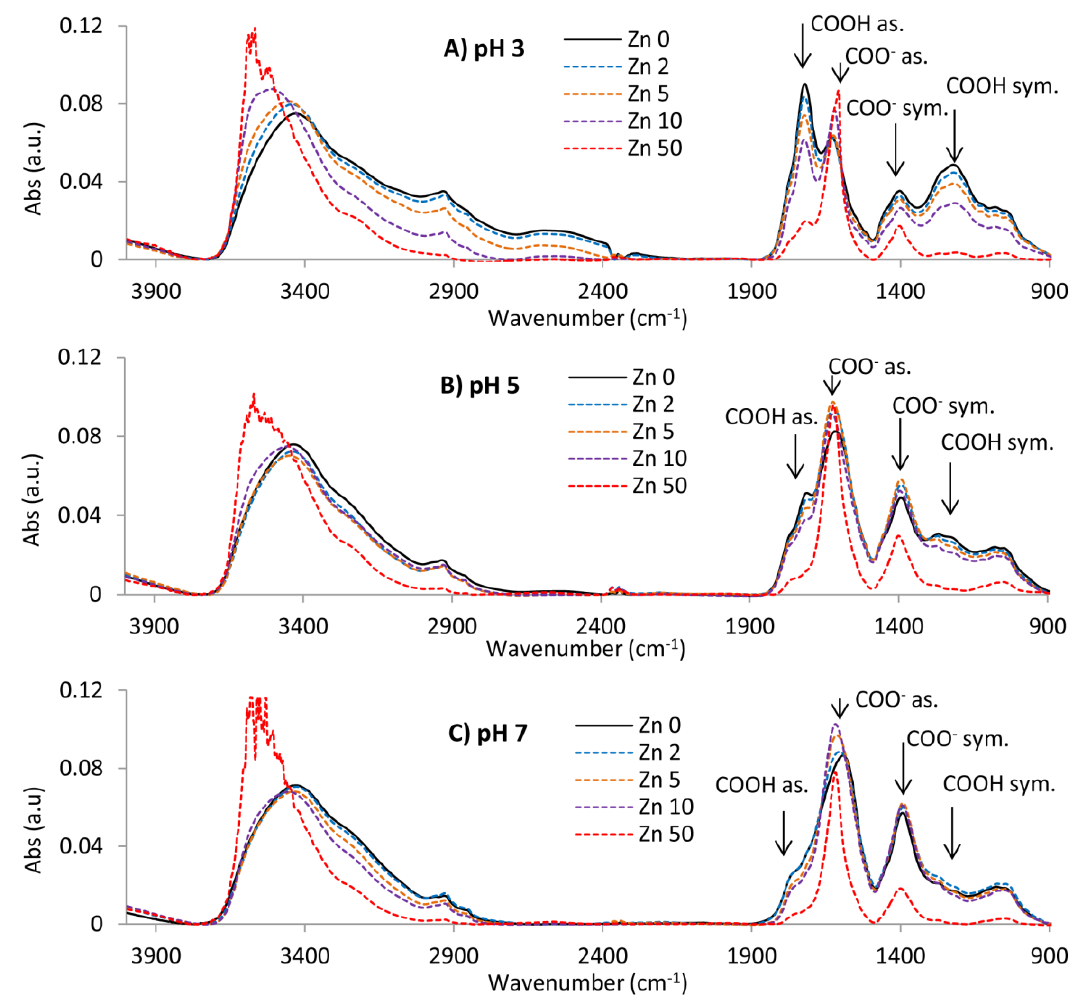
Figure 5. FTIR spectra of the FA4-Zn(II) complexes at increasing metal concentration and at ( A ) pH 3; ( B ) pH 5; and ( C ) pH 7.